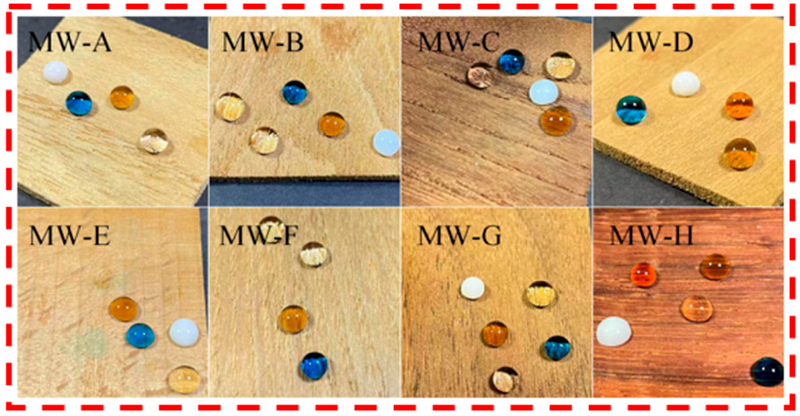
Figure 8. Di ff erent pollutants on modi fi ed wood （ water, tea, co ff ee, milk, methylene blue ） . Figure 8. Different pollutants on modified wood (water, tea, coffee, milk, methylene